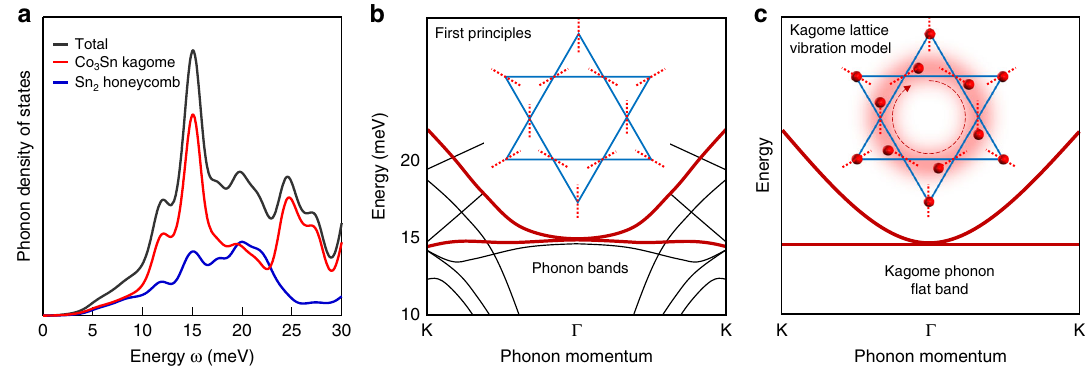
Fig. 4 Kagome fl at-band origin of the bosonic mode. a Calculated layer-resolved phonon density of states, showing a pronounced peak at 15 meV arising from the Co 3 Sn kagome layer. b Calculated phonon band structure, showing a fl at-band at 15 meV. The inset shows the calculated atomic displacements for the kagome lattice associated with the phonon fl at-band, where the dotted lines denote the atomic vibration directions. c Phonon band structure for the kagome lattice vibration model. The inset shows the collective atomic vibrations associated with the phonon fl at-band.